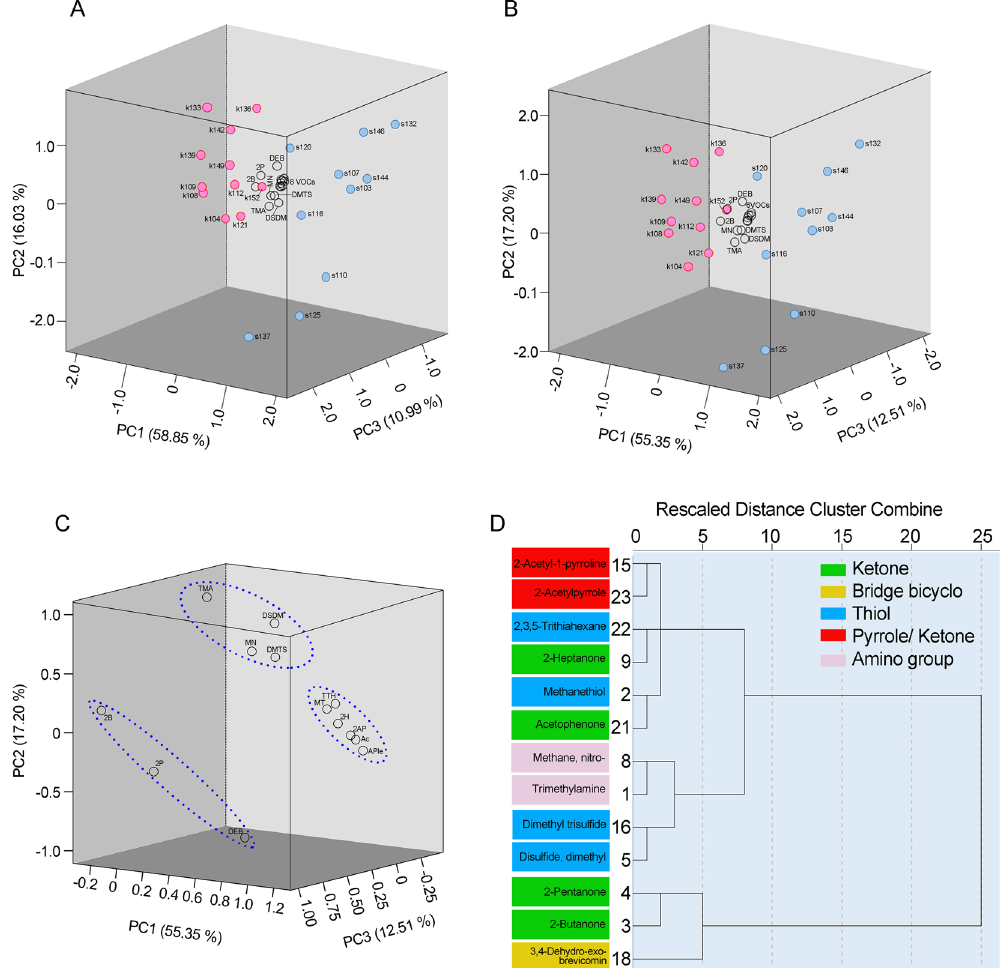
Figure 3. Evaluation of VOCs related with kindled seizures using principal component analysis (PCA). The principal component analysis (PCA) scores plot was derived from absolute values of 15 VOCs ( A ) and 13 VOCs ( B ) in the urine of amygdala-kindled and sham-operated mice. PC1 to PC3 scores of kindled mice (red circles), sham operated mice (blue circles), and PC1 to PC3 standardized scoring coefficients (black circles) in the principal component score coefficient matrix of each VOC were represented as the X-, Y-, and Z-axis, respectively. Promax rotation with Kaiser normalization was applied to the PCA with 13 VOCs, and components 1 to 3 of the pattern matrix of each VOC were represented as the X-, Y-, and Z-axis, respectively ( C ). A dendrogram of 13 VOCs was derived with the Ward method from the component scores 1 to 6 of each VOC ( D ). The vertical axis shows the number described in Table 1. Abbreviations: 2-acetyl-pyrroline, 2AP; 2-acetylpyrrole, APle; 2-butanone, 2B; 2-heptanone, 2H; 2-pentanone, 2P; acetophenone, Ac; 3,4-dehydro-exo- brevicomin, DEB; dimethyl trisulfide, DMTS; disulfide, dimethyl, DSDM; methane, nitro-, MN; methanethiol, MT; trimethylamine, TMA; 2,3,5-trithiahexane, TTH. The 6 VOCs include 2AP, 2H, Ac, APle, and MT, TTH in B; the 8 VOCs include the 6 VOCs in B and RI1227 and RI1449 in